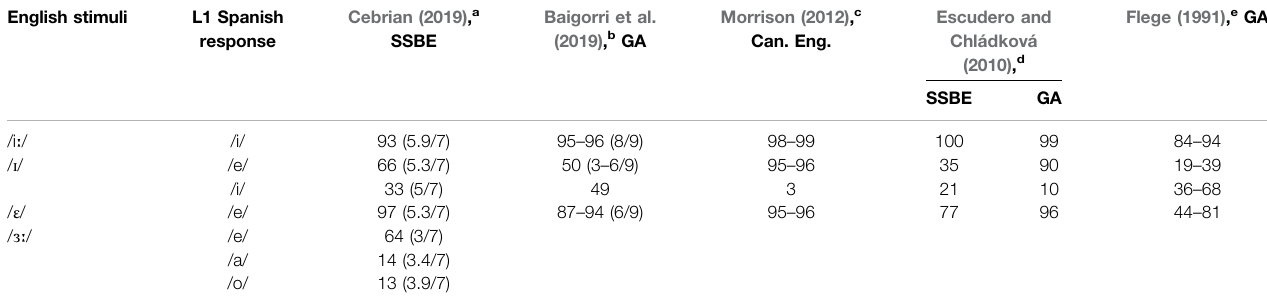
TABLE1| PercentassimilationofEnglish/i ː , ɪ , ε , ɜ ː /toSpanishvowelsreportedinrecentstudies(Goodnessof fi tratingsaregiveninparentheseswhenavailable).SSBE,GA (General American) and Can. Eng. (Canadian English) indicate the English variety of the